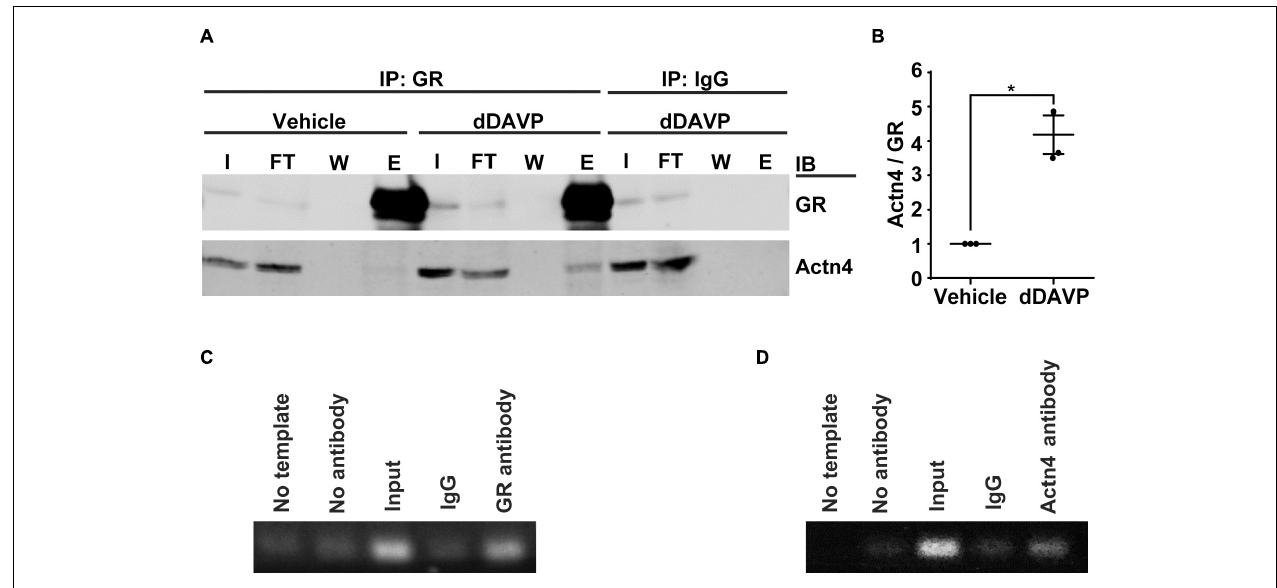
FIGURE 2 | Vasopressin enhanced interactions between α -actinin 4 and glucocorticoid receptor in the mpkCCD cells. (A) Co-immunoprecipitation (IP) of glucocorticoid receptor (GR) followed by immunoblotting (IB) for α -actinin 4 (Actn4) in the mpkCCD cells under vehicle vs. dDAVP (1nM, 24 h) conditions. (B) Summary from three independent experiments. Numbers are means ± SEM, summarized from three independent experiments. Asterisk indicates statistical significance, t -test p < 0.05. E, eluate; FT, flow through; I, input; W, wash. (C,D) Chromatin immunoprecipitation with antibody against GR, Actn4, or IgG followed by PCR amplification of AQP2 between –128 and –255 base pairs upstream to the AQP2 transcription start site.